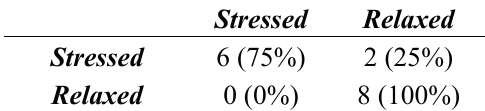
= Carbon dioxide 2